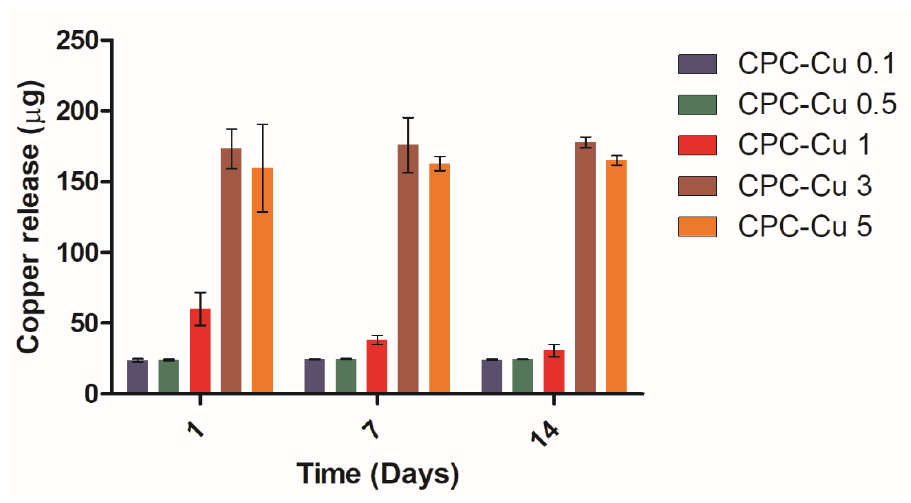
Figure 3. The plot shows the copper release in 14 days from CPC-Cu scaffolds in PBS at pH 7.4. The data are represented as mean ± standard deviation for n = 3.